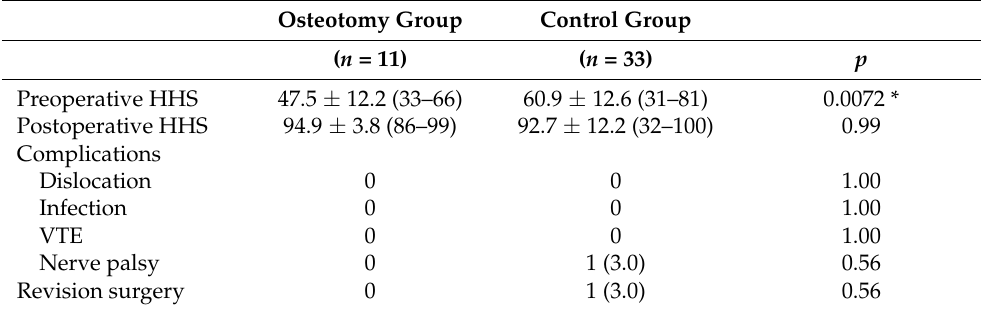
Table 3. Clinical